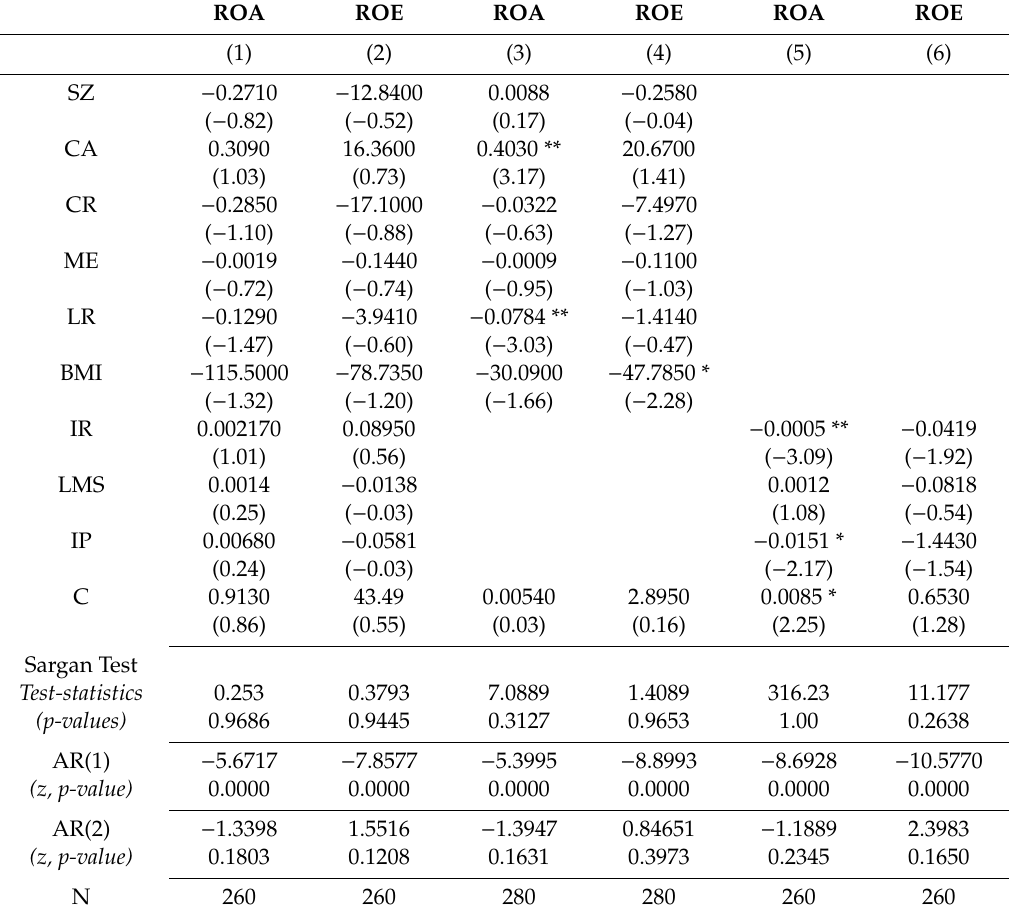
Table 4. Impact of bank-specific and macroeconomic determinants on financial performance—Arellano– Bond